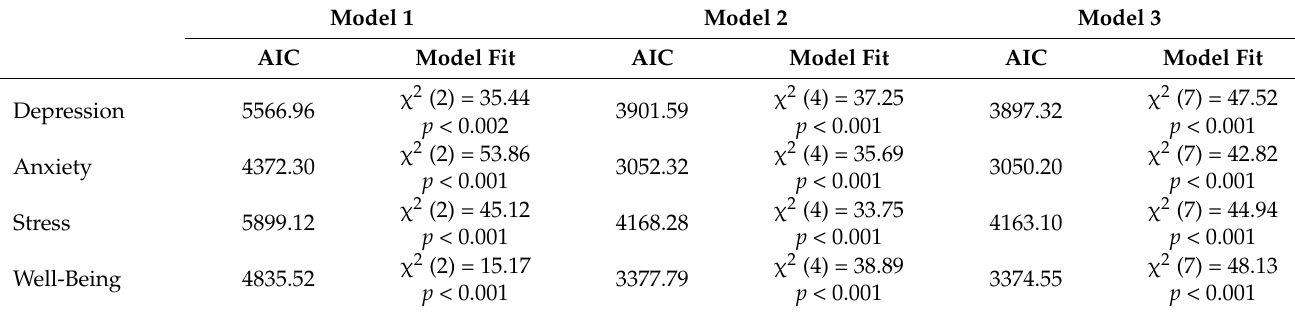
Table 3. Model fit statistics for outcome